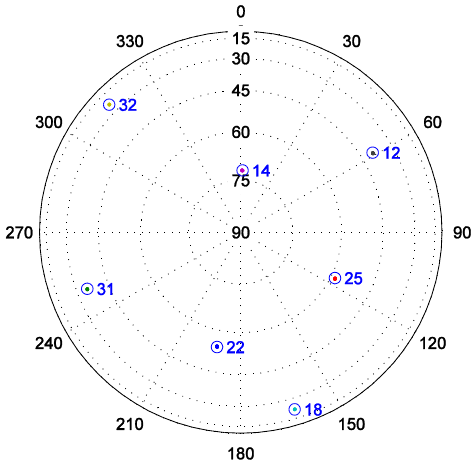
Figure 3. Satellites sky plot of the field test.